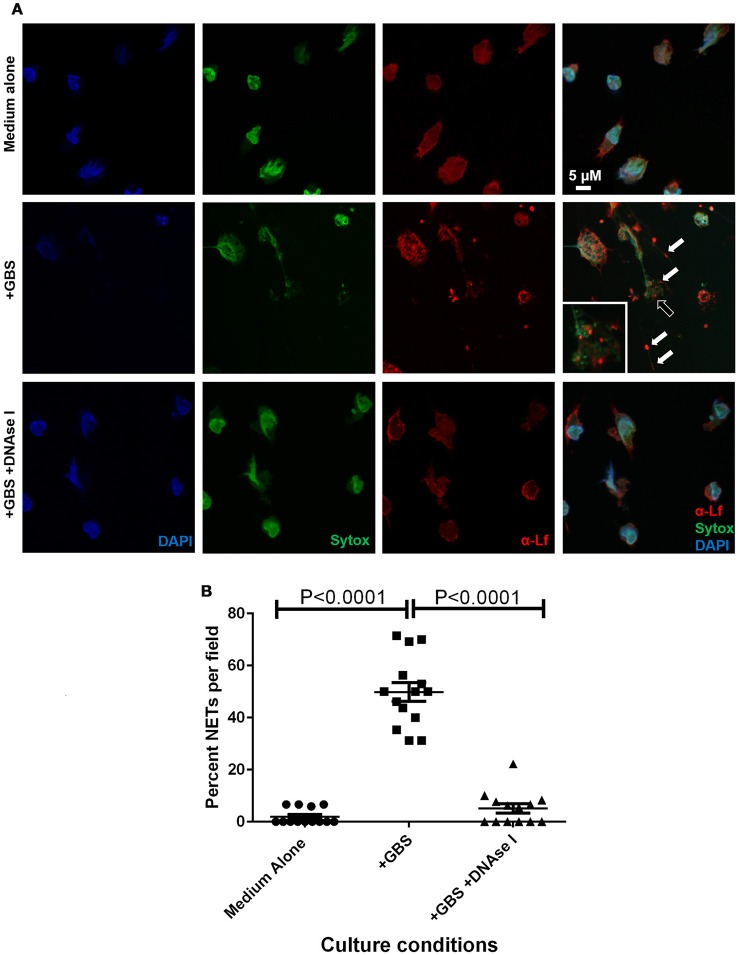
Extracellular traps formed in response to GBS are decorated with lactoferrin. Panel (A) Confocal laser scanning microscopy analyses of neutrophils cultured in the absence of GBS (Medium Alone), in the presence of GBS (+GBS) alone or in co-cultures supplemented with DNAse I (+GBS +DNAse I) were subjected to intracellular nuclear DNA stain (DAPI, blue), extracellular DNA stain (Sytox, green), or antibody to lactoferrin (α-Lf). Merge images reveal that GBS co-culture with neutrophils results in the elaboration of neutrophil extracellular traps comprised of extracellular DNA (representative images of N = 3 biological replicates). These traps immobilize GBS (black arrow), and are studded with lactoferrin (white arrow) which is found in close contact with GBS, indicating lactoferrin is part of the antimicrobial repertoire secreted in the NETs in response to GBS. Panel (B) Enumeration of the percentage of NETs per field was performed, and demonstrate that NETs are enriched in GBS-containing co-cultures, but are ablated by treatment with DNAse I (Bars indicate mean percent of NETs per field ± SEM, P < 0.0001, One Way ANOVA, N = 3 biological replicates and at least five fields per replicate, 150+ cells total).